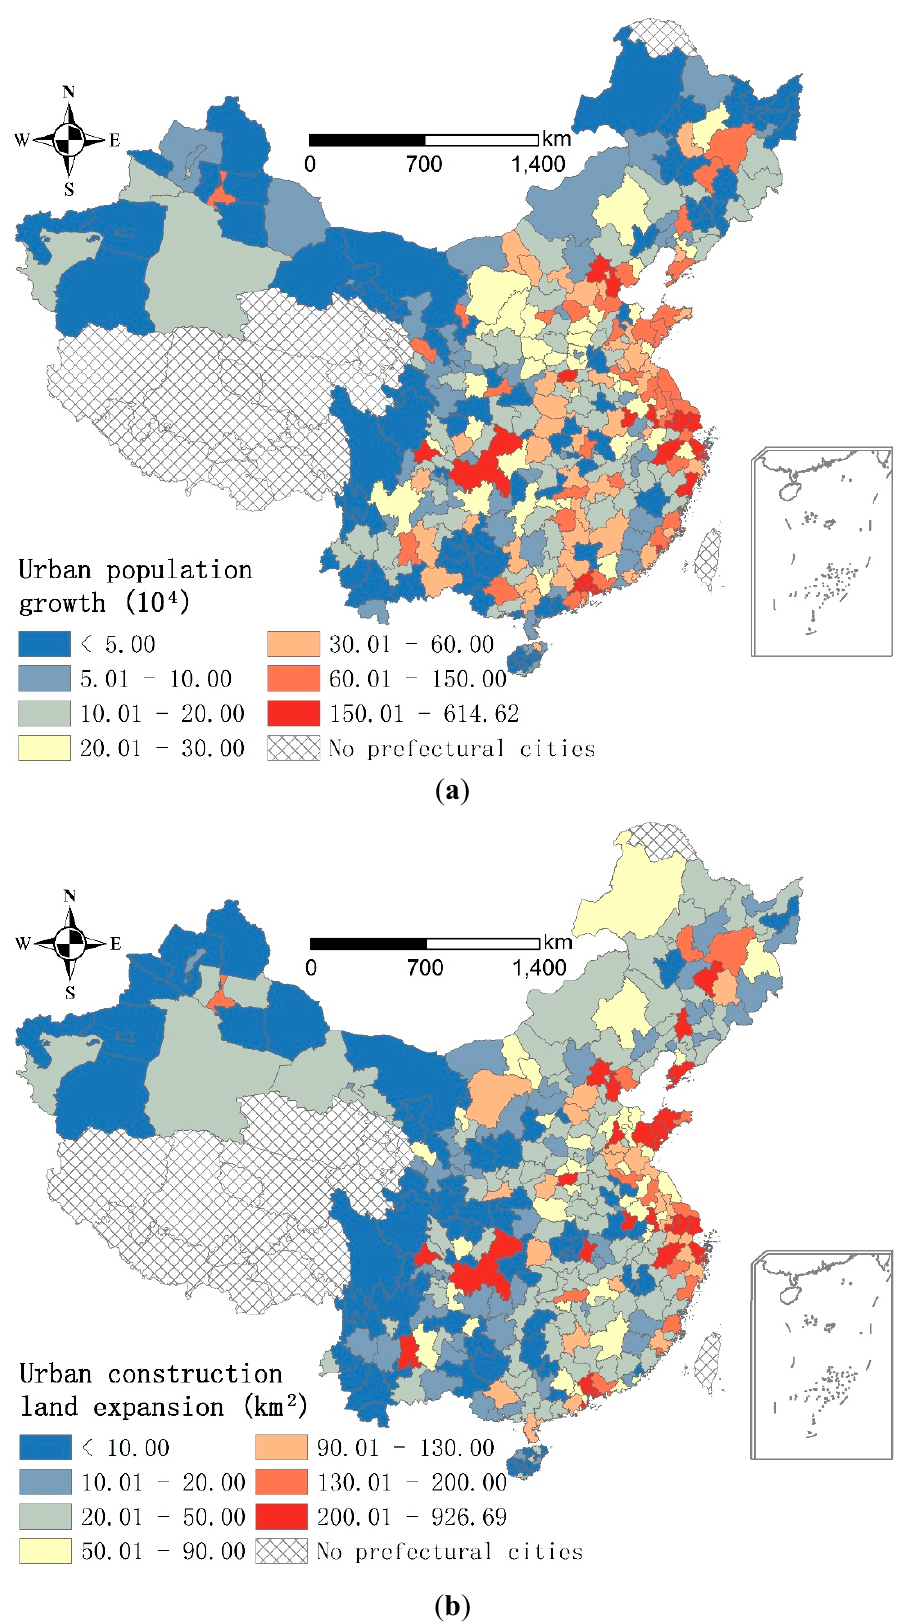
Figure 1. Urban population growth and urban construction land expansion in the prefectural cities, China, 2000–2010. ( a ) Urban population growth (10 4 ); ( b ) Urban construction land expansion (km 2 ).